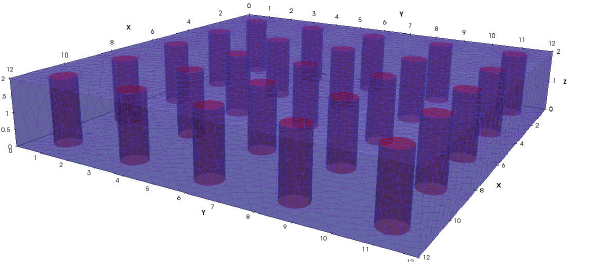
Figure 6: Generated 3D finite element mesh for Dam